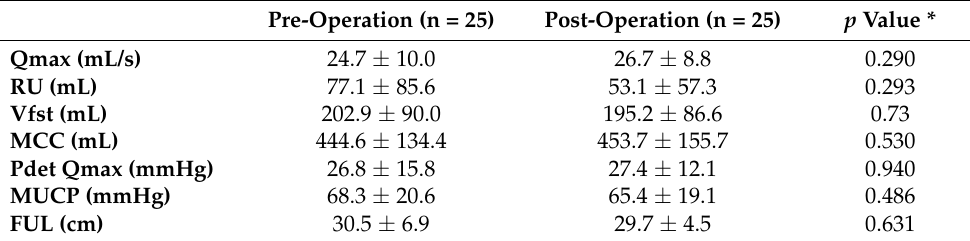
Table 3. Urodynamic changes at baseline and 6 months post-treatment. Data are given as mean ± standard deviation.